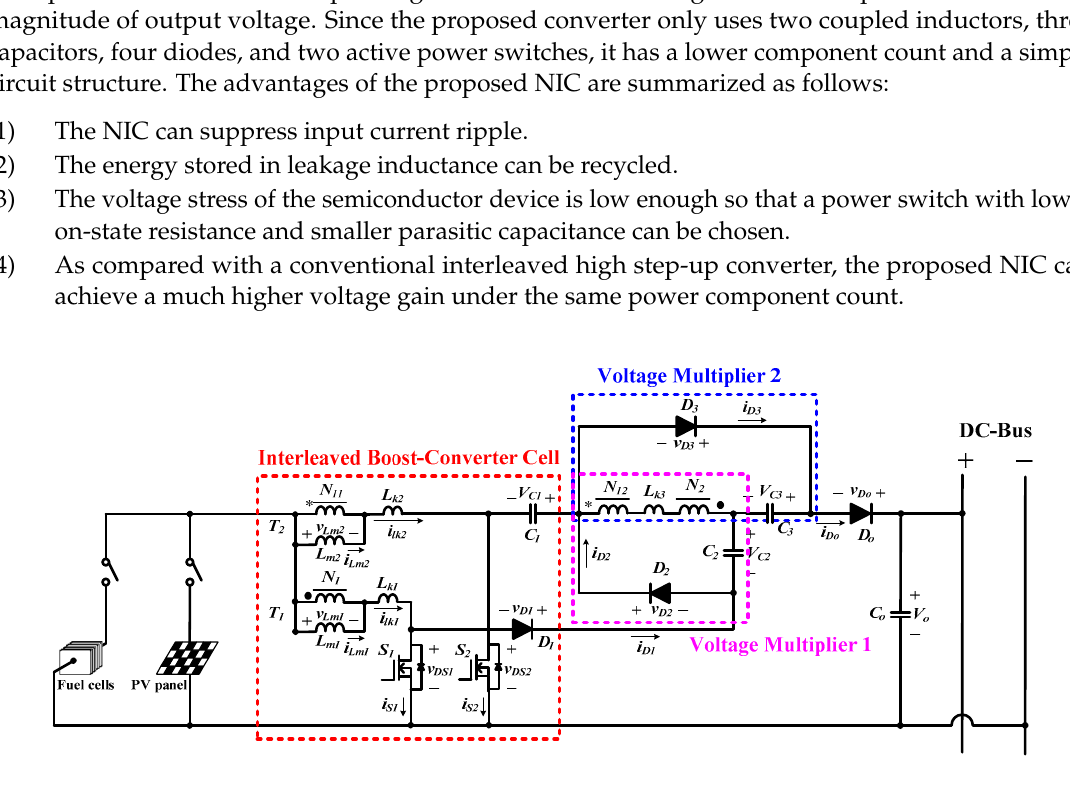
Figure 1. The main power circuit of the proposed novel interleaved converter (NIC). PV: photovoltaic.